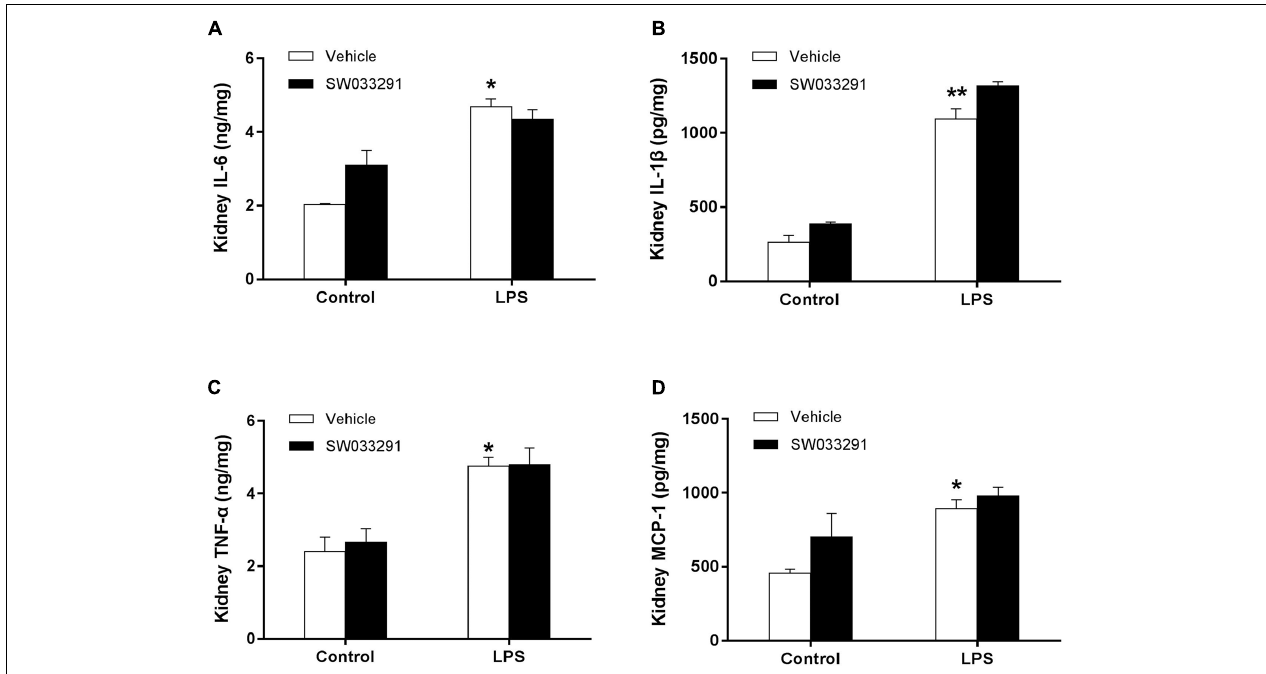
FIGURE 8 | Effect of 15-PGDH inhibition on the release of inflammatory cytokines in kidneys of AKI mice. (A) IL-6. (B) IL-1 β . (C) TNF- α . (D) MCP-1. * P < 0.05, ** P < 0.01 (compared with control group); ( n = 6). Results were analyzed with Two-Way ANOVA. Data are mean ± SD.